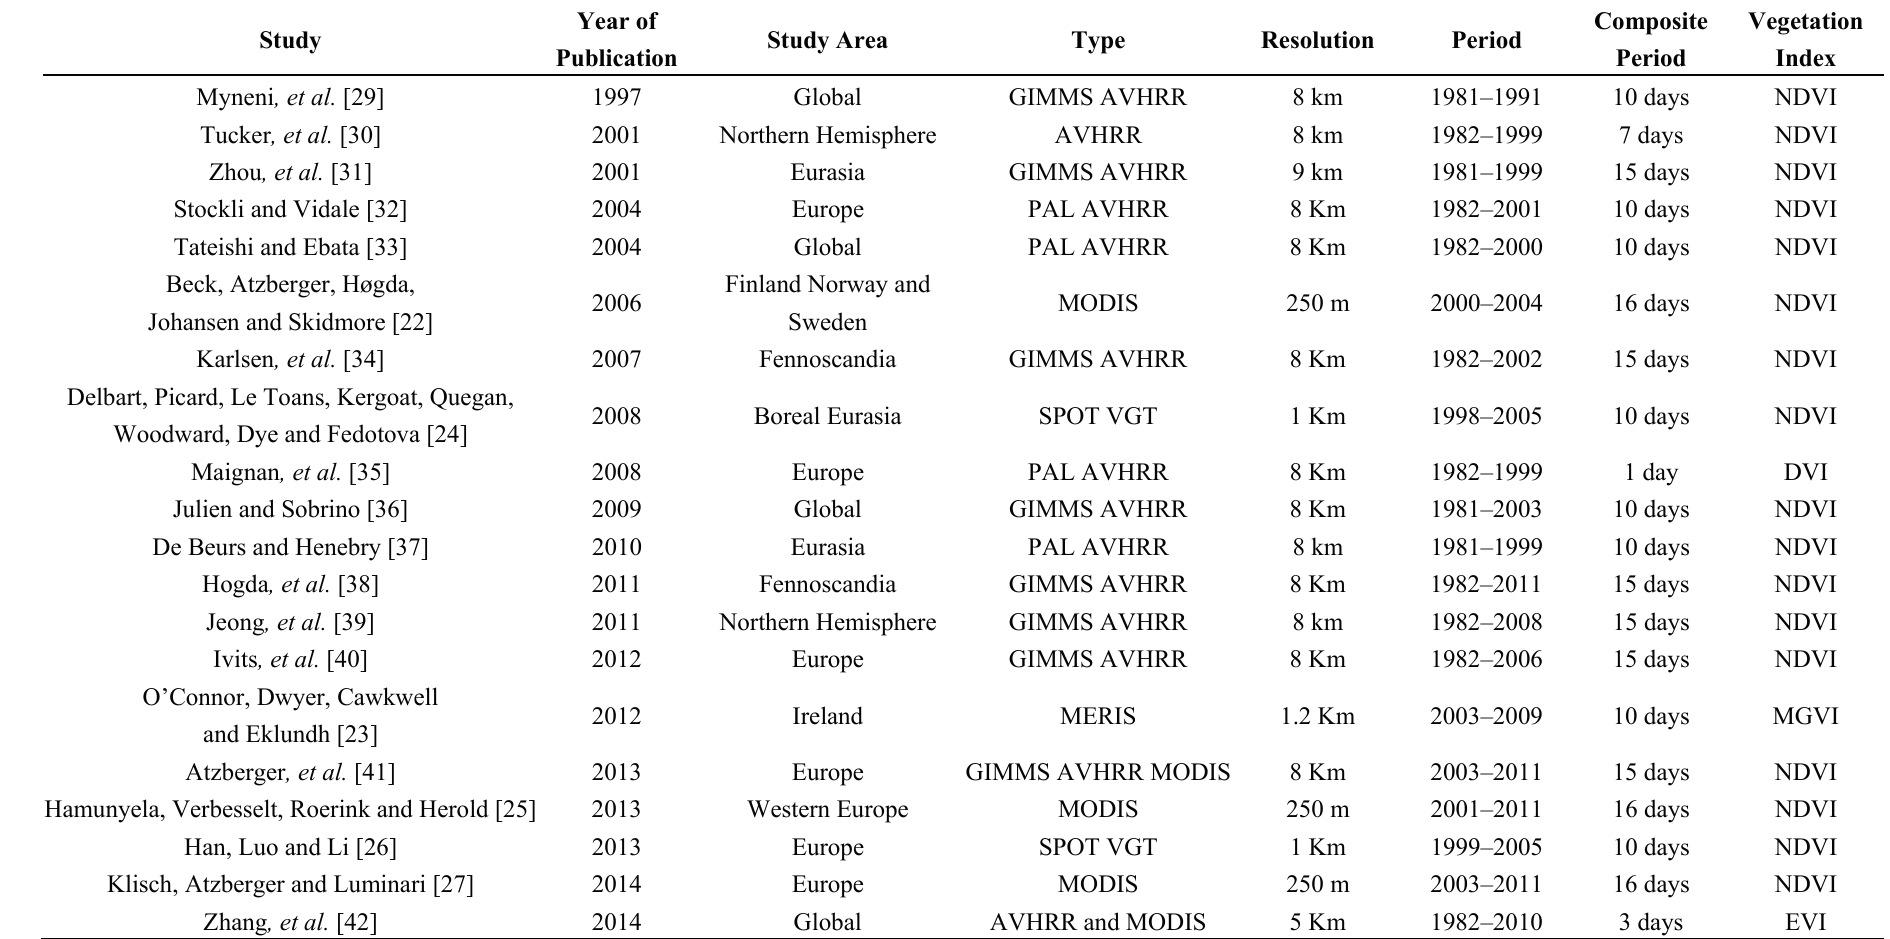
Table 1. Land surface phenology studies in Europe. AVHRR, Advanced Very High Resolution Radiometer; GIMMS, Global Inventory Modelling and Mapping Studies; PAL, Path finder AVHRR Land; MODIS, Moderate Resolution Imaging Spectroradiometer; SPOT, Satellite Pour l'Observation de la